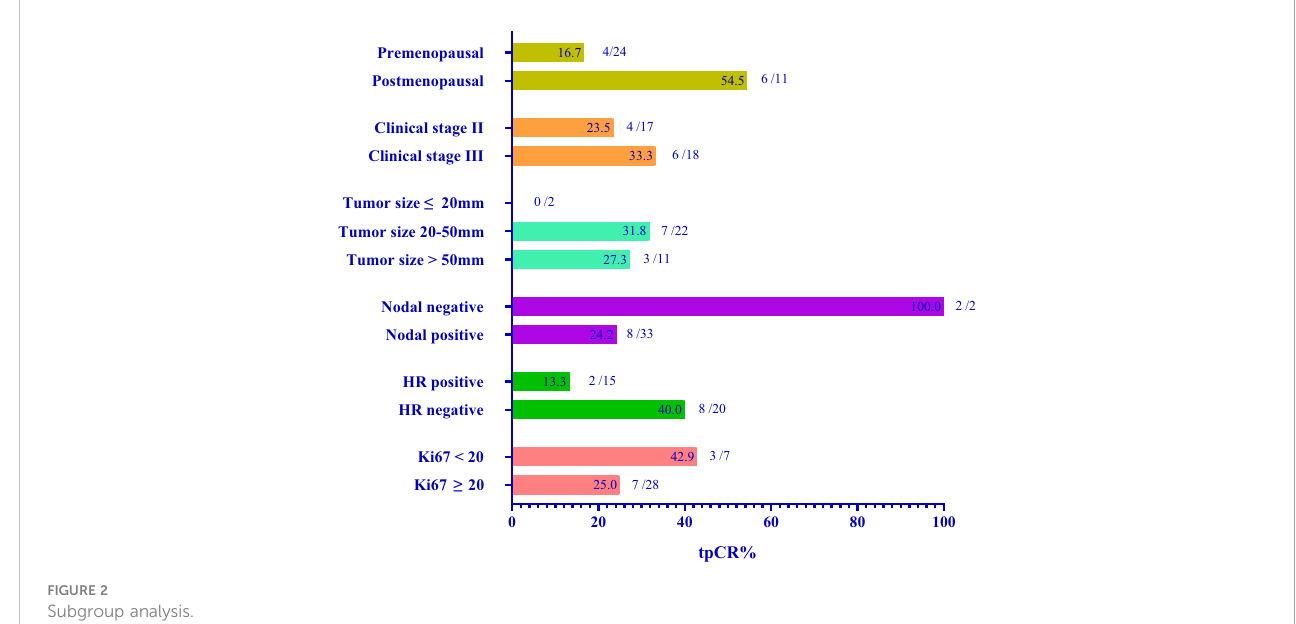
FIGURE 2 Subgroup